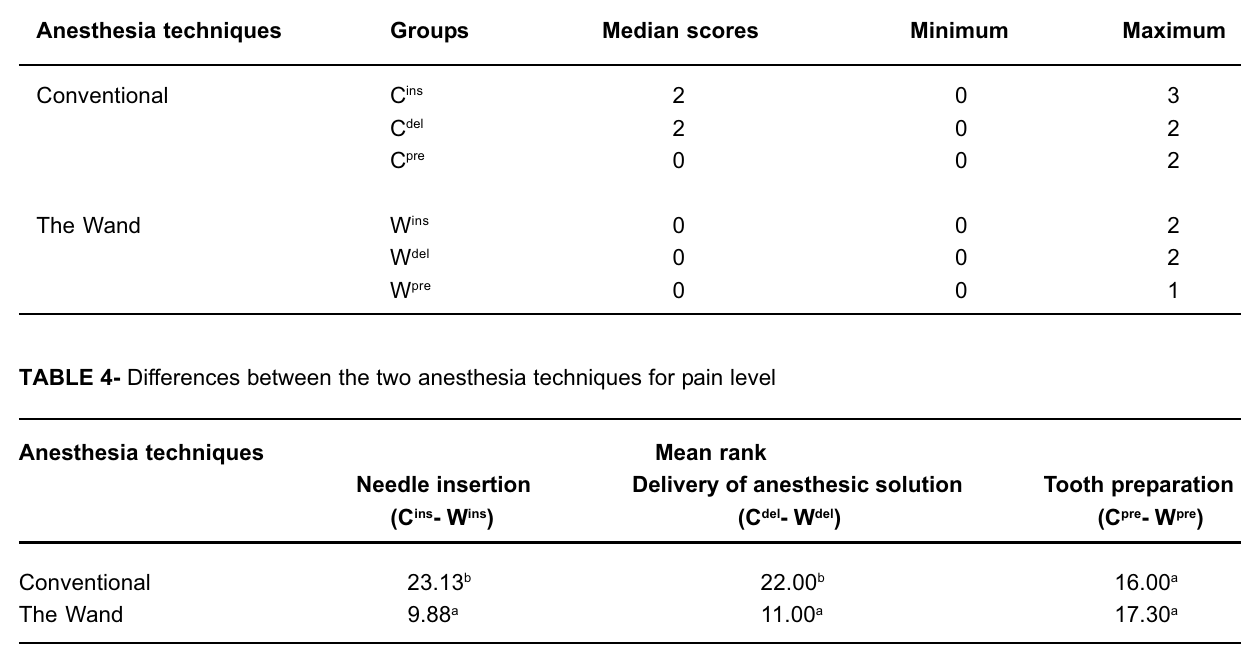
Different letters in same column indicate statistically significant difference at 1%